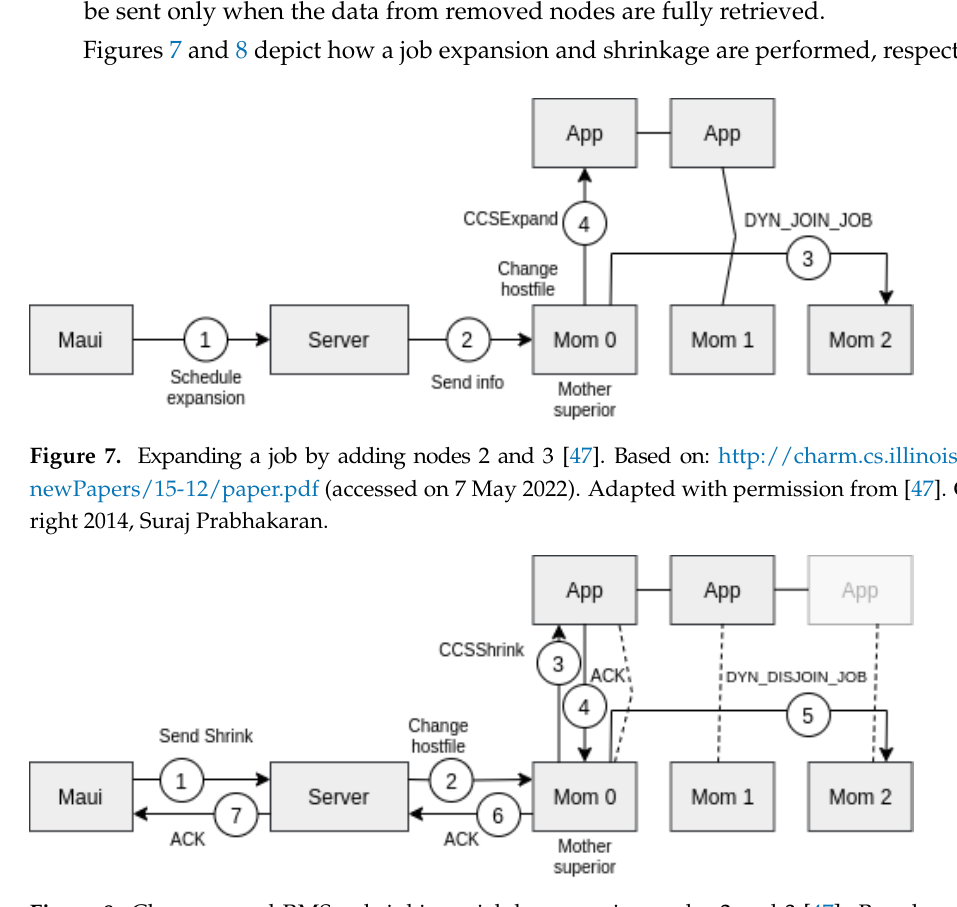
Figure 8. Charm++ and RMS—shrinking a job by removing nodes 2 and 3 [47]. Based on: http: //charm.cs.illinois.edu/newPapers/15-12/paper.pdf (accessed on 7 May 2022). Adapted with permission from [47]. Copyright 2014, Suraj